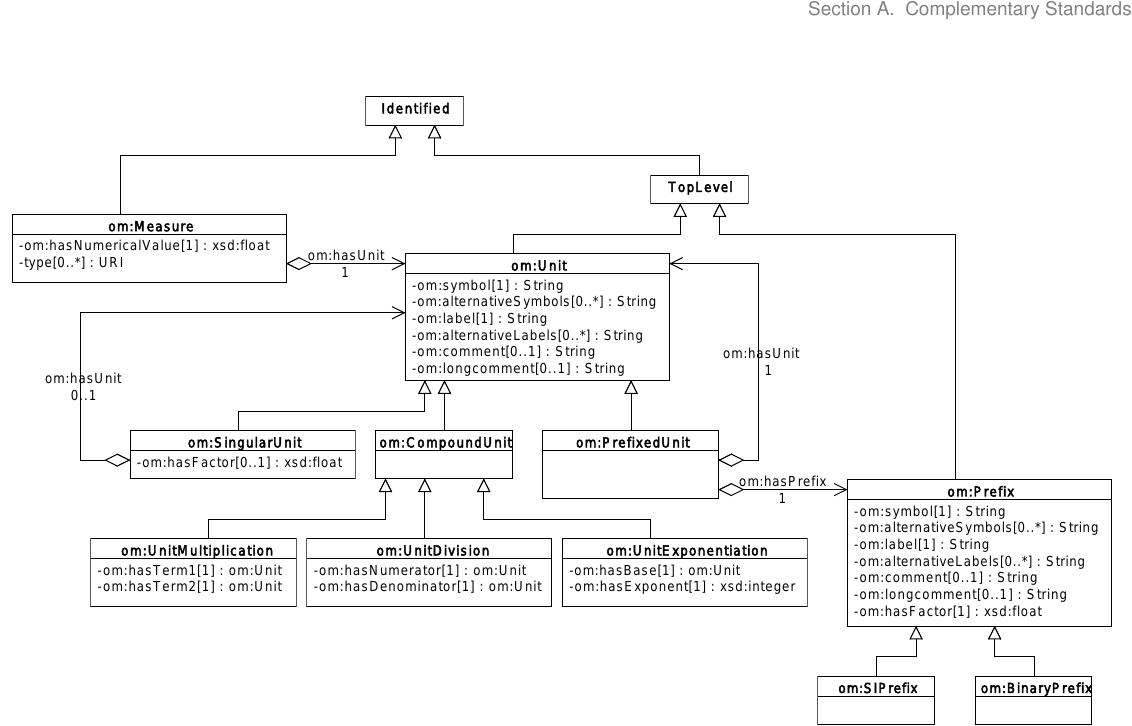
Figure 29: OM classes adopted by SBOL and their subclass relationships to Identified and